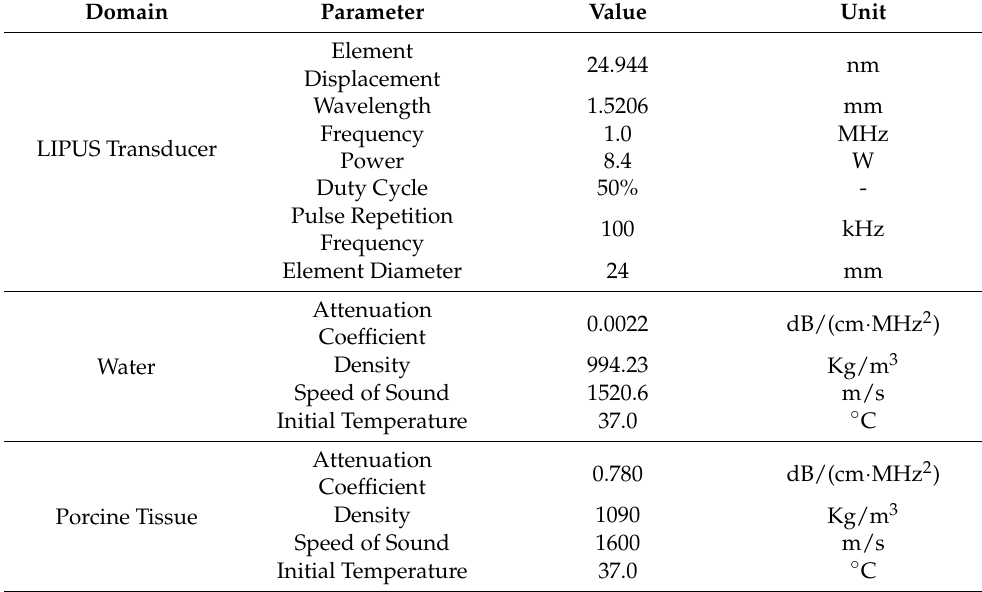
Table 1. Key parameters used in the pressure acoustics and BHT simulation. The material parameters were taken from